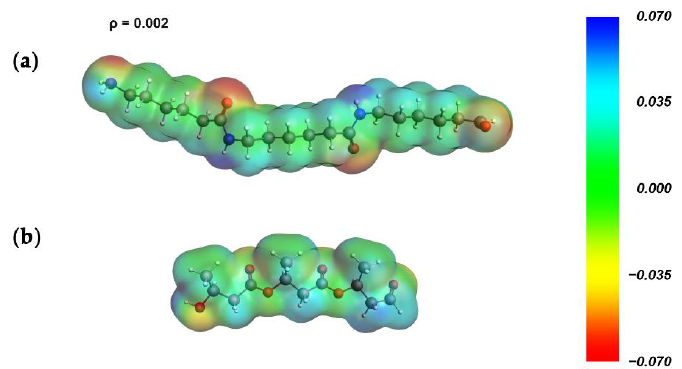
Figure 7. Molecular electrostatic potential map of ( a ) nylon 6 and ( b ) PHB models. The analysis of the computational details effect allowed us to estimate, that the